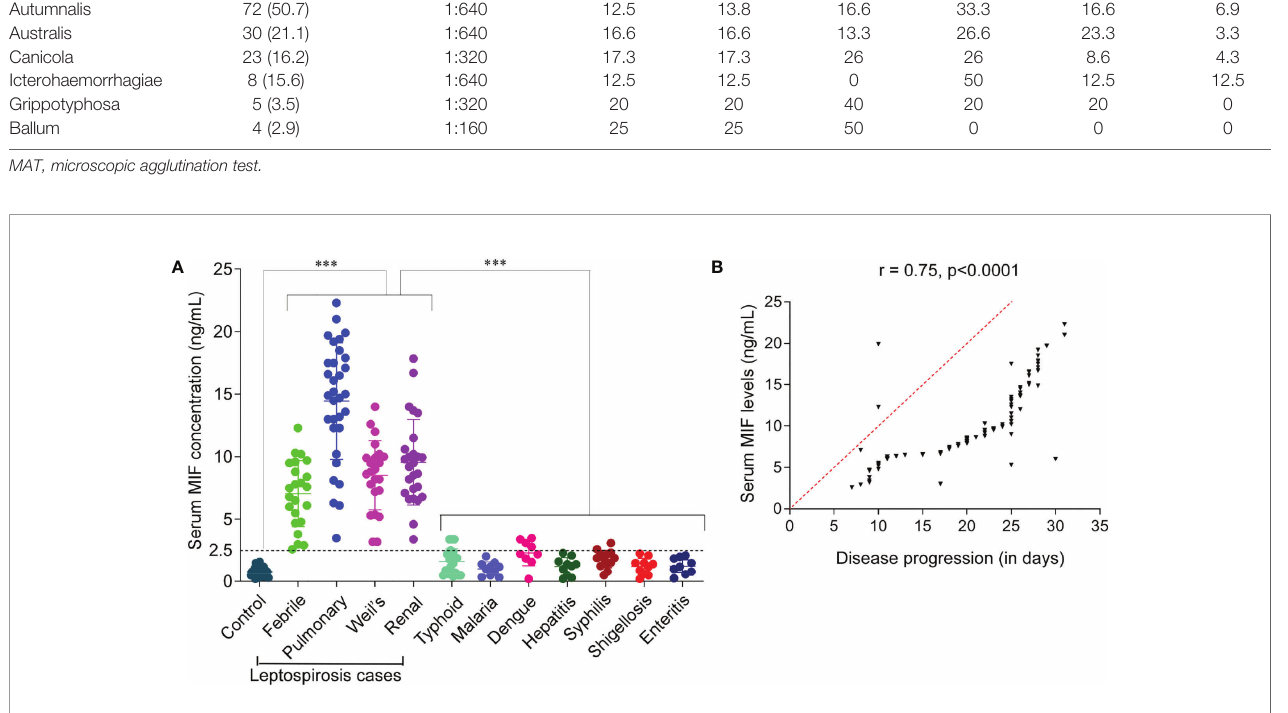
TABLE 2 | Serovar distribution and MAT titers in the study subjects. Serovar